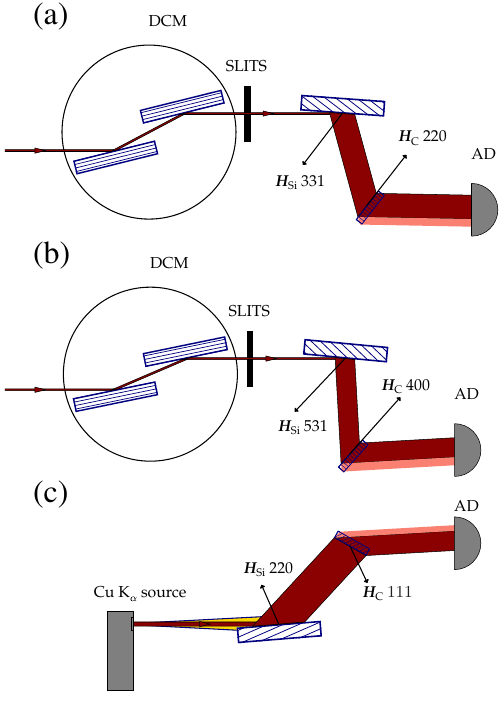
Figure 1. Experimental configurations for rocking curve topography of (110)-edge oriented diamond plates ( a and c ) and (100)-edge oriented diamond plates ( b ). DCM—double crystal Si 111